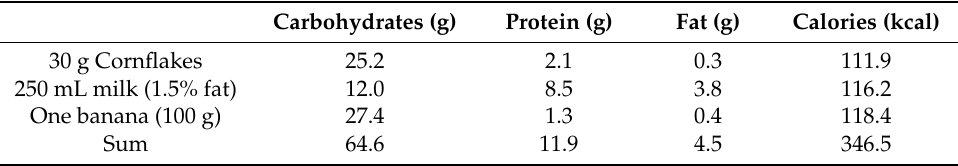
Table 1. Compositions and calories of the standardized